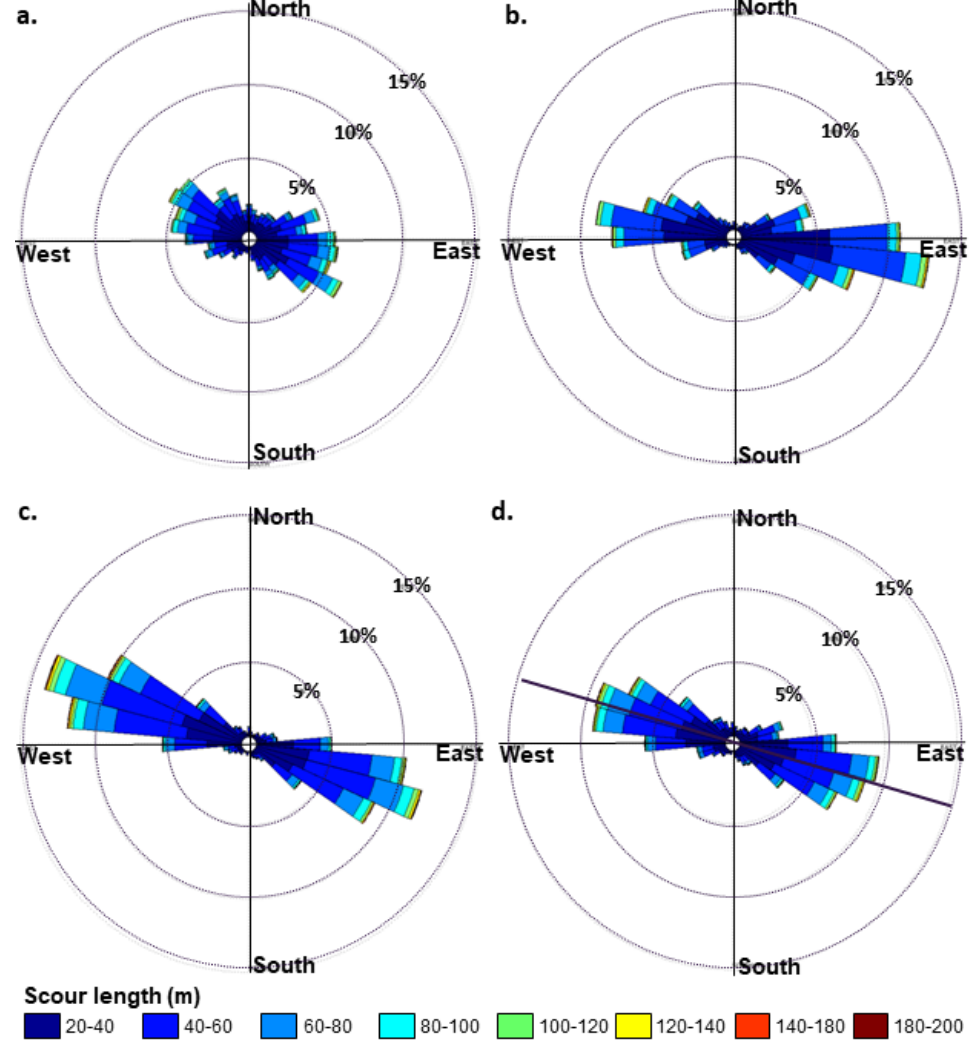
Figure 5. Rose diagrams of observed scour direction for each of the area analyzed. ( a ) Area 1; ( b ) Area 2; ( c ) Area 3; and ( d ) combined areas.